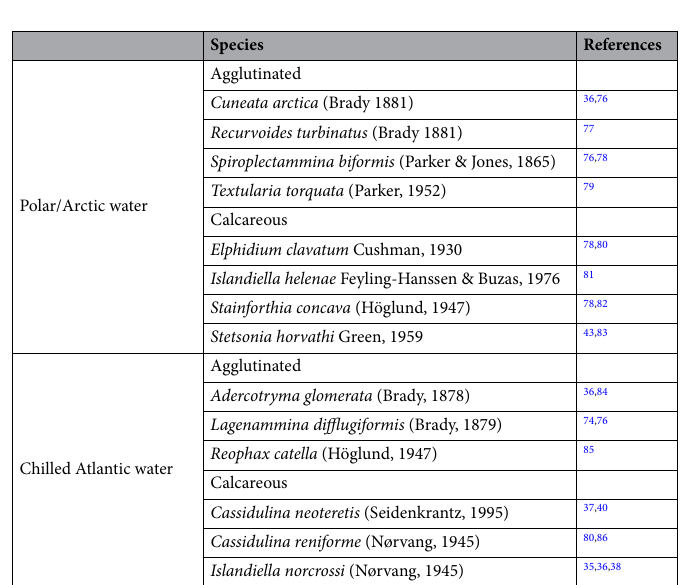
Table 2. List of benthic foraminiferal key species and associations used in this study.